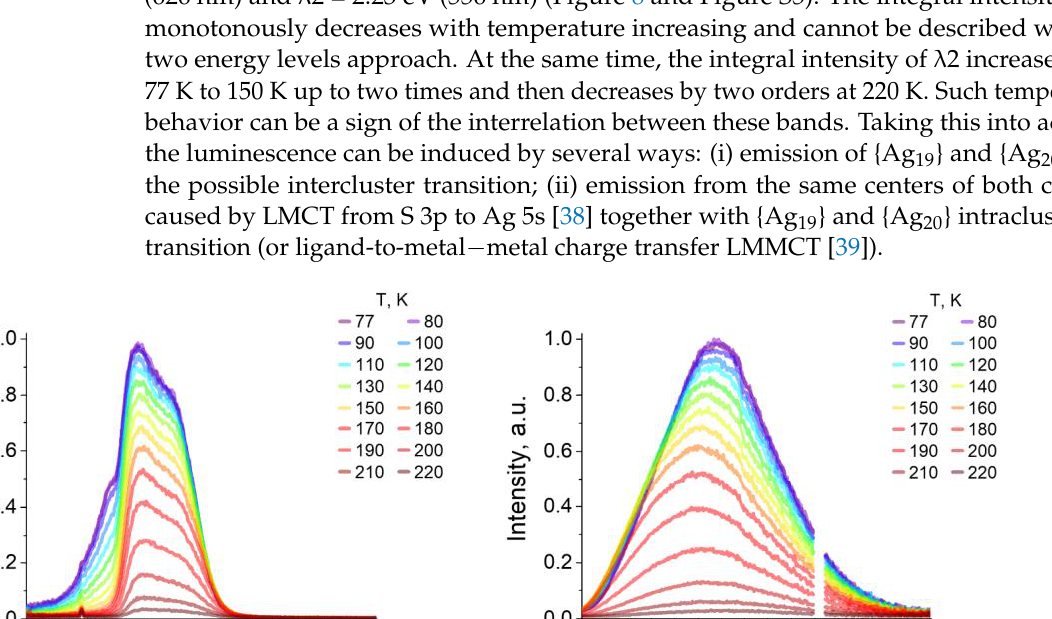
Figure 8. PL spectrum (λ ex = 400 nm) of 1 at 300 K with two Gauss approximation in direct energy units (λ 1 = 1.98 eV, λ 2 = 2.23 eV) ( left ); temperature dependence of the PL bands integral intensities (λ Ex = 400 nm) of 1 using two Gauss approximation (λ 1 = 1.98 eV, λ 2 = 2.23 eV) ( right ). The temperature dependence of the luminescence in 2 is shown in Figure 9. The PL spectra at each temperature consist of two well-resolved bands and can be described by at least two Gauss functions with maxima λ 1 = 1.73 eV (717 nm) and λ 2 = 2.03 eV (611 nm) (Figure S6). The integral intensities of both bands monotonously decrease with tempera- ture increasing (Figure 9, right).